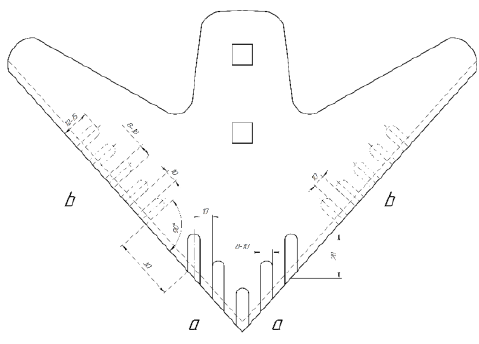
Fig.8. The scheme of reinforcing stripes